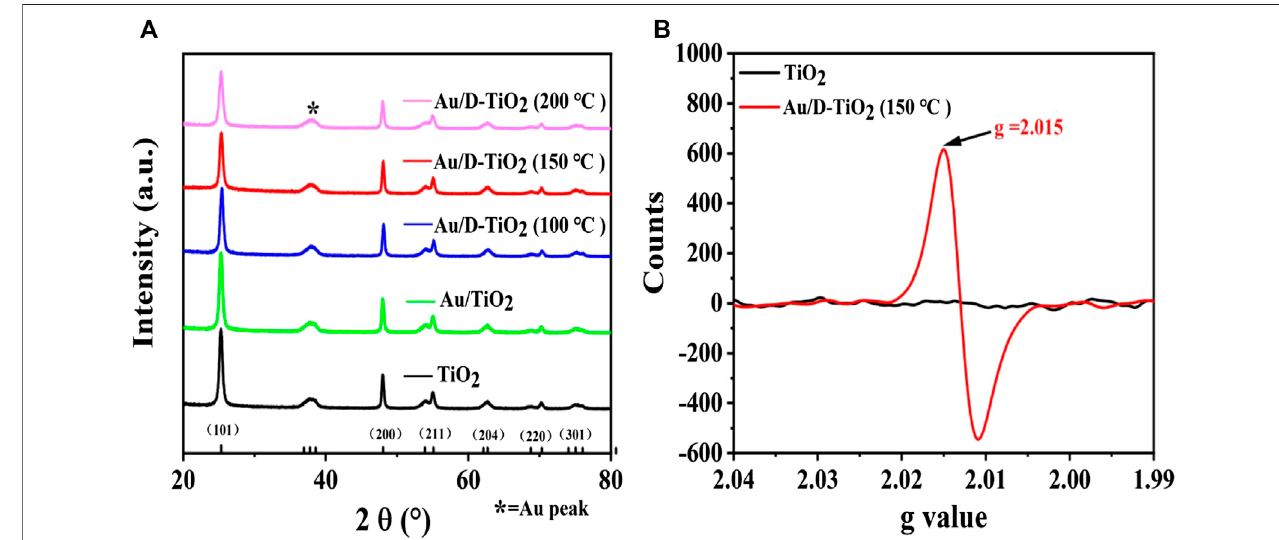
FIGURE1|(A) XRDofpureTiO 2 ,Au/TiO 2, andAu/D-TiO 2 (TheD-TiO 2 weretreatedat100 ° ,150 ° ,and200 ° C,respectively) (B) EPRofTiO 2 andAu/D-TiO 2 (treated at 150 ° C).